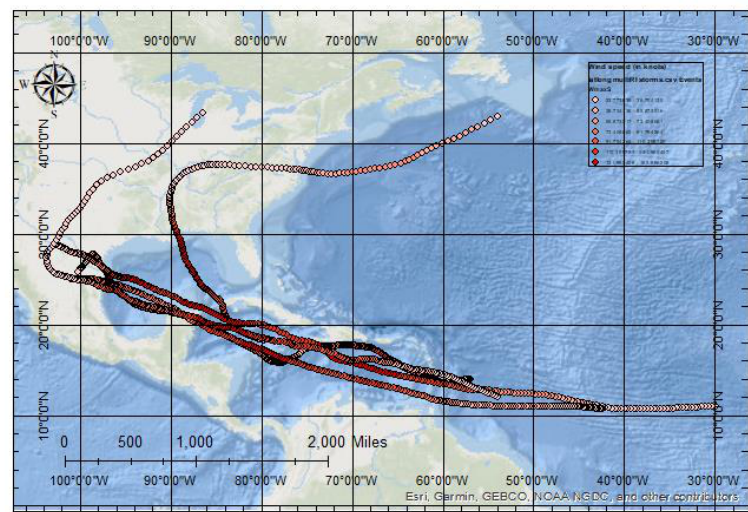
Figure 18. Tracks of the five storms that underwent 4 RI cycles with their intensity delineated by darkening red shades. (Beulah (1967), Camille (1969), Allen (1980), Gilbert (1988), and Emily (2005)). The high rate of RI storms within this sub-basin may be due to the more evenly distributed heating that the sub-basin receives throughout the summer months, as well as the higher temperatures the Gulf of Mexico is known to have in comparison to the North Atlantic. The Gulf of Mexico is also a more compact, shallower body of water, which allows for the hot water temperatures to occur during the entirety of the Boreal summer